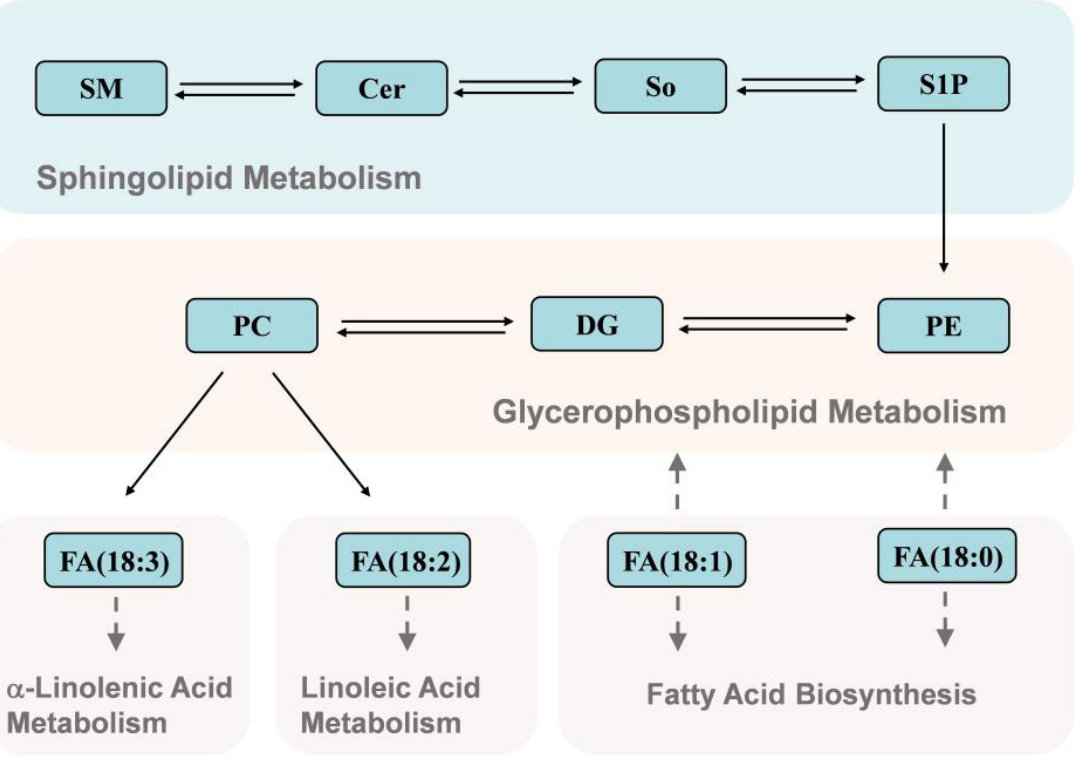
Figure 5. Kyoto Encyclopedia of Genes and Genomes (KEGG) biological pathway annotations for the detected lipids. SM, sphingomyelin; Cer, ceramide; So, sphingosine; S1P, sphingosine-1-phos- phate; PE, phosphatidylethanolamine; DG, 1,2-diacyl-sn-glycerol; PC, phosphatidylcholine.